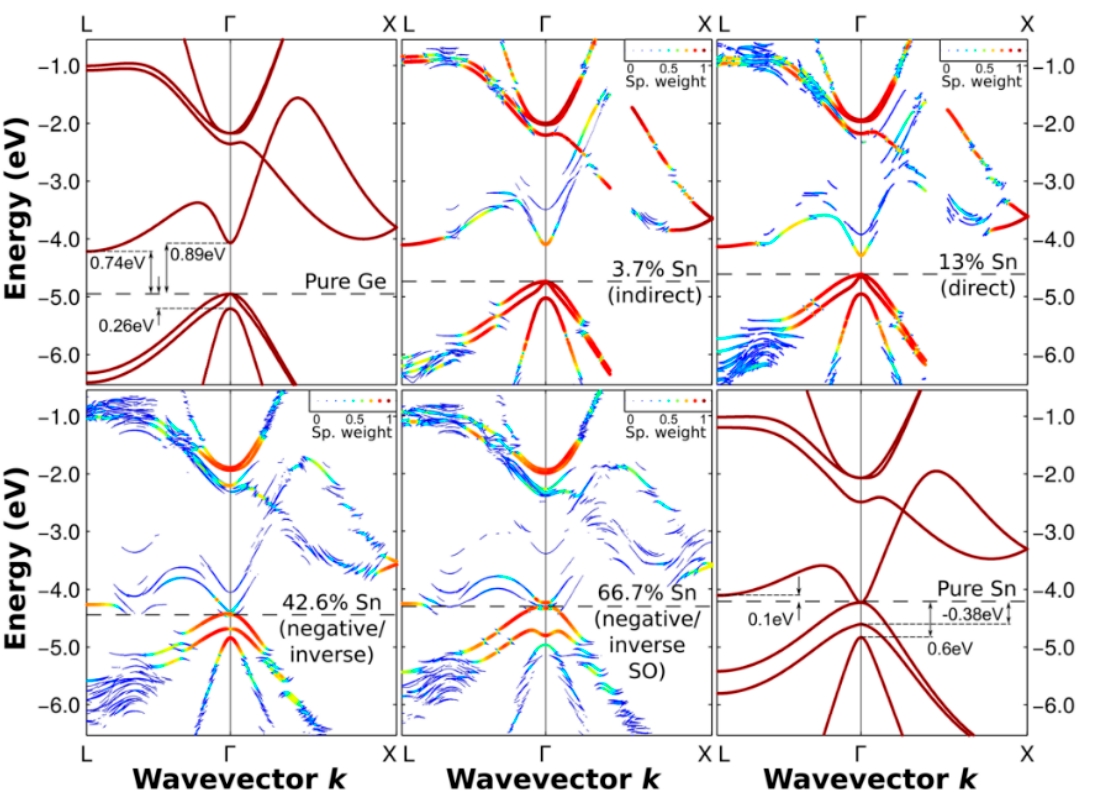
Figure 9. Band structures of bulk Ge and α -Sn (first and last figures, respectively), GeSn materials with various compositions (3.7%, 13%, 42.6%, and 66.7%). The color and point size denote the Bloch spectral weight, and the points with weights lower than 0.05 are neglected. Reproduced with permission from [46], IOP Publishing, 2017.